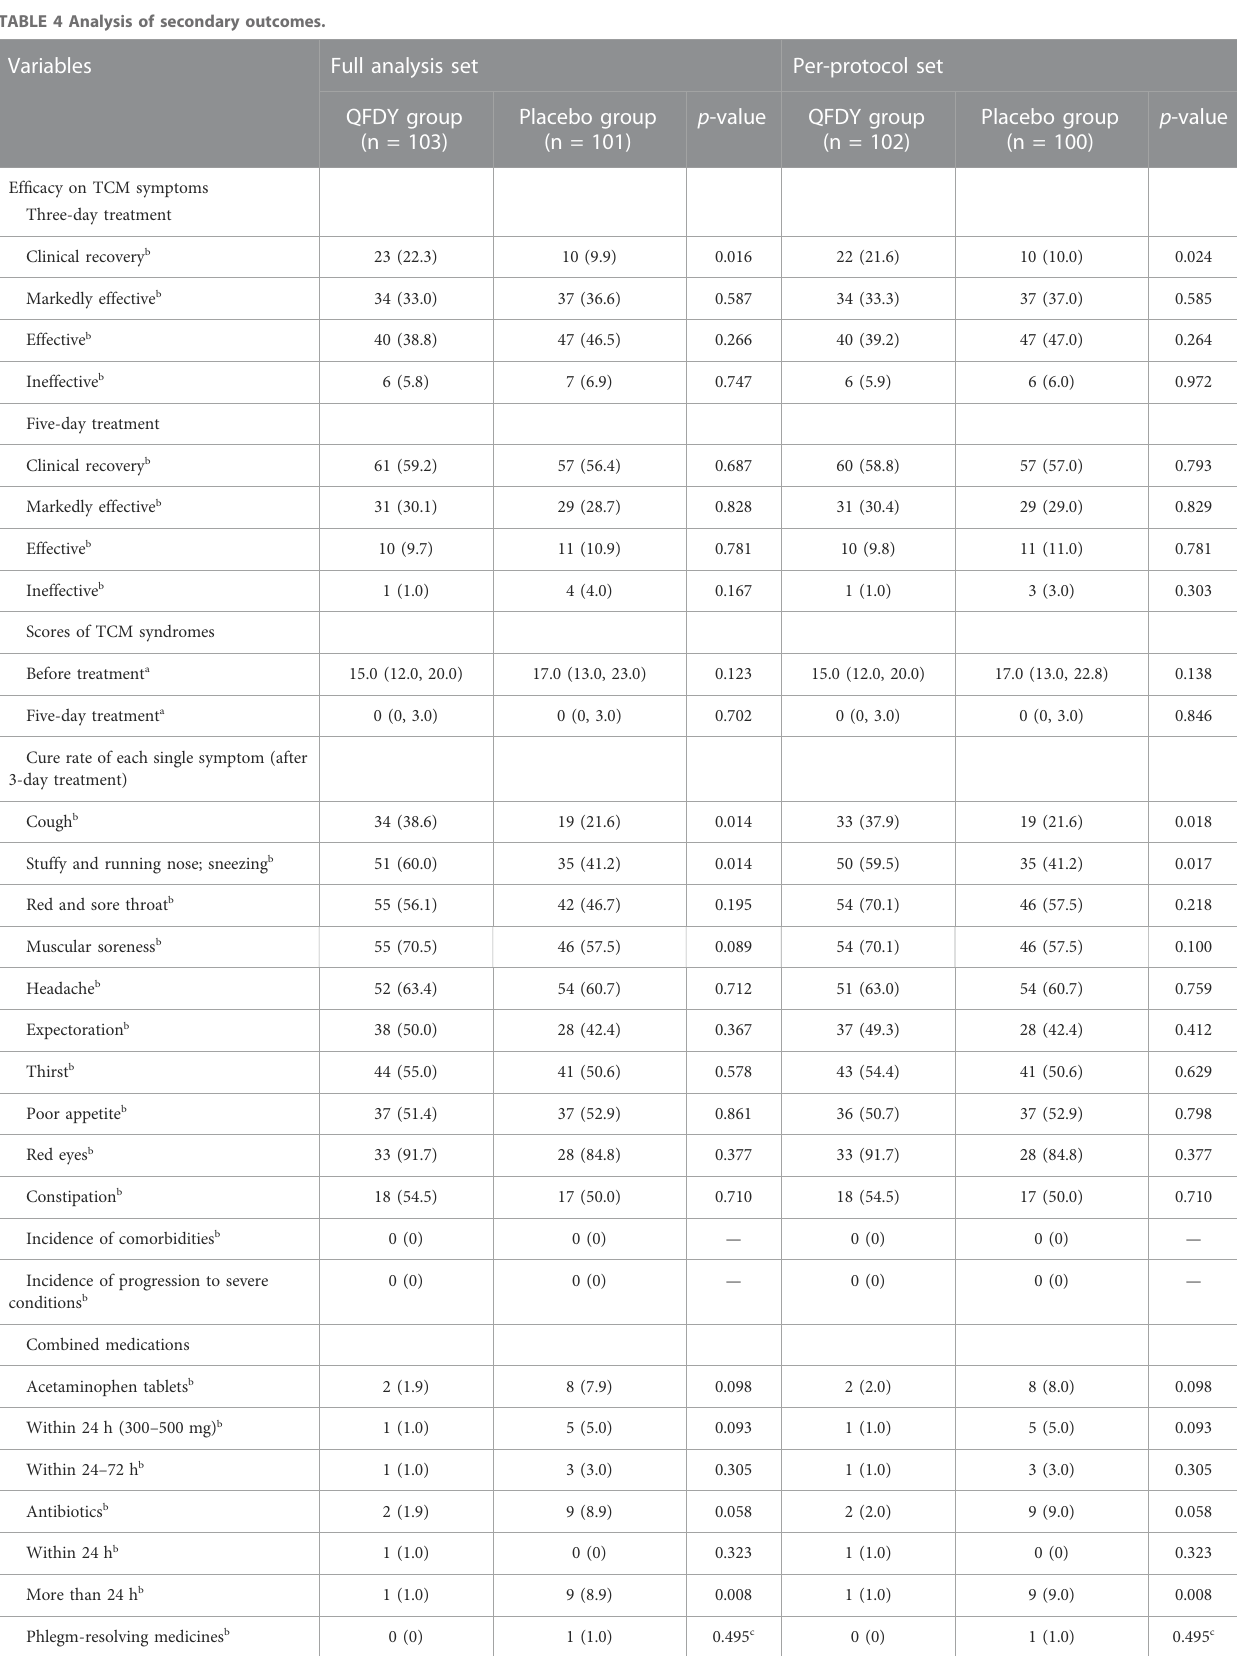
TABLE 4 Analysis of secondary